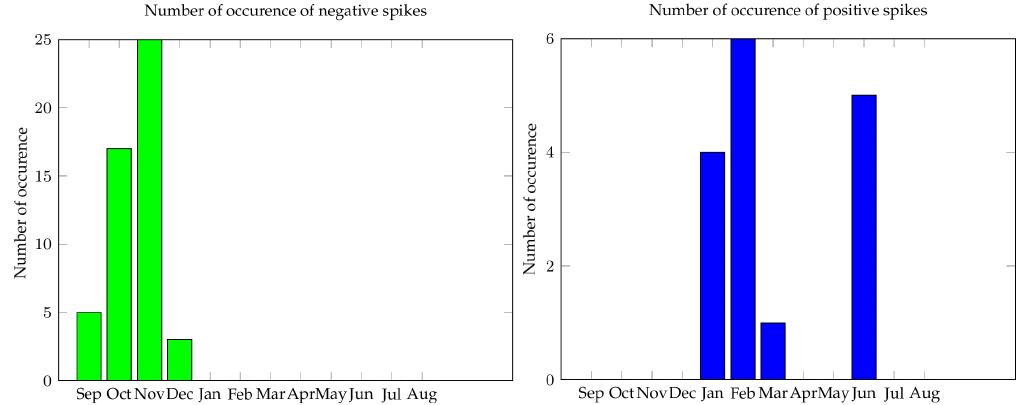
Figure 3. Occurrences of